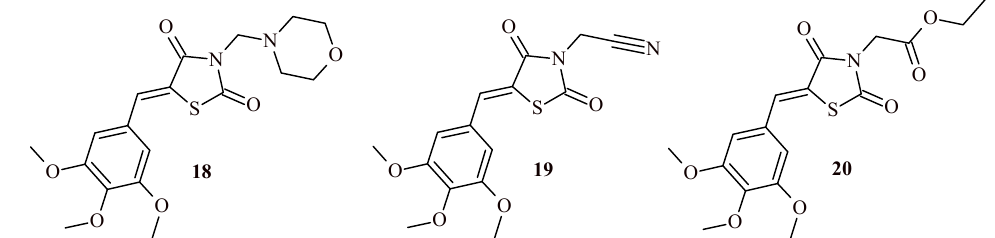
Figure 10. The 5-(3,4,5-trimethoxybenzylidene)thiazolidine-2,4-dione derivatives with anti-breast cancer activity.